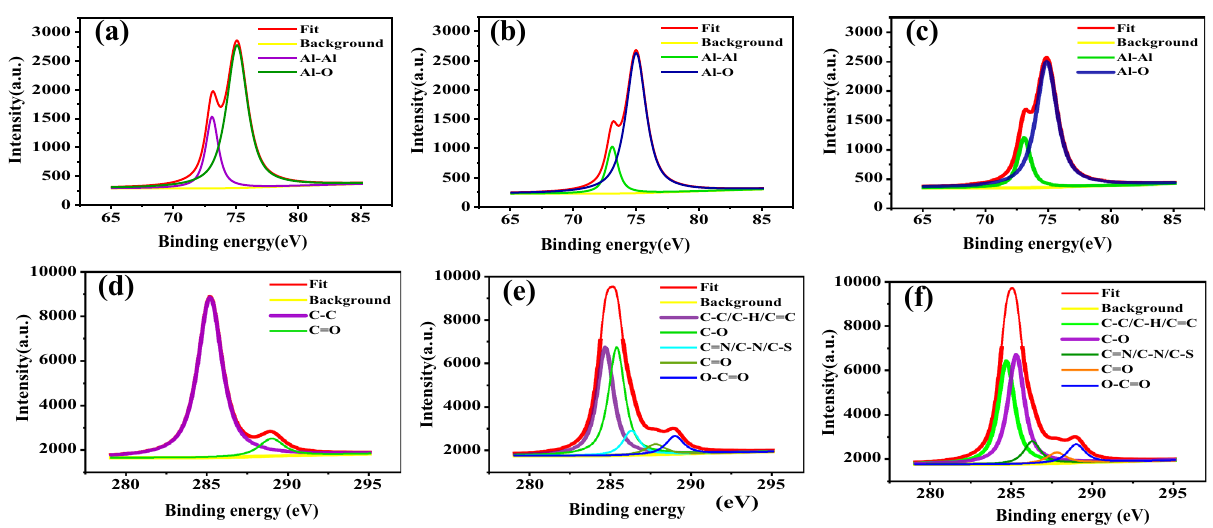
Figure 10. High-resolution XPS spectra carried out in the Al 2p and C 1s binding energy range for Al in 0.1 M NaOH solution in the absence and presence of 300 ppm of Cefx and Cefz at 293 K; Al 2p ( a ) blank, ( b ) Cefx, ( c ) Cefz respectively and C 1s ( d ) blank, ( e ) Cefx, ( f ) Cefz